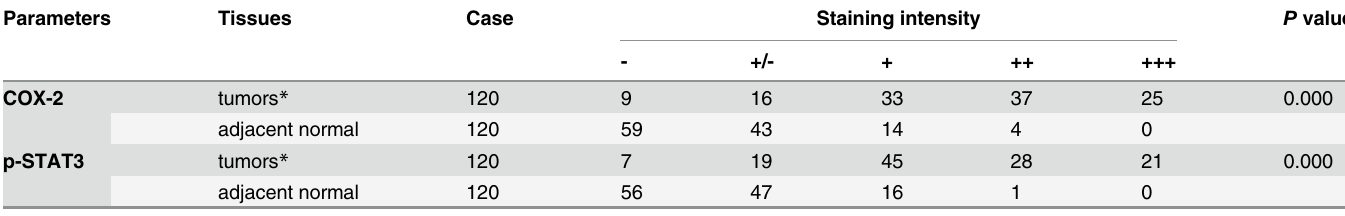
Table 1. Immunohistochemistry of COX-2 and p-STAT3 in human CRC tissues and adjacent normal tissues.